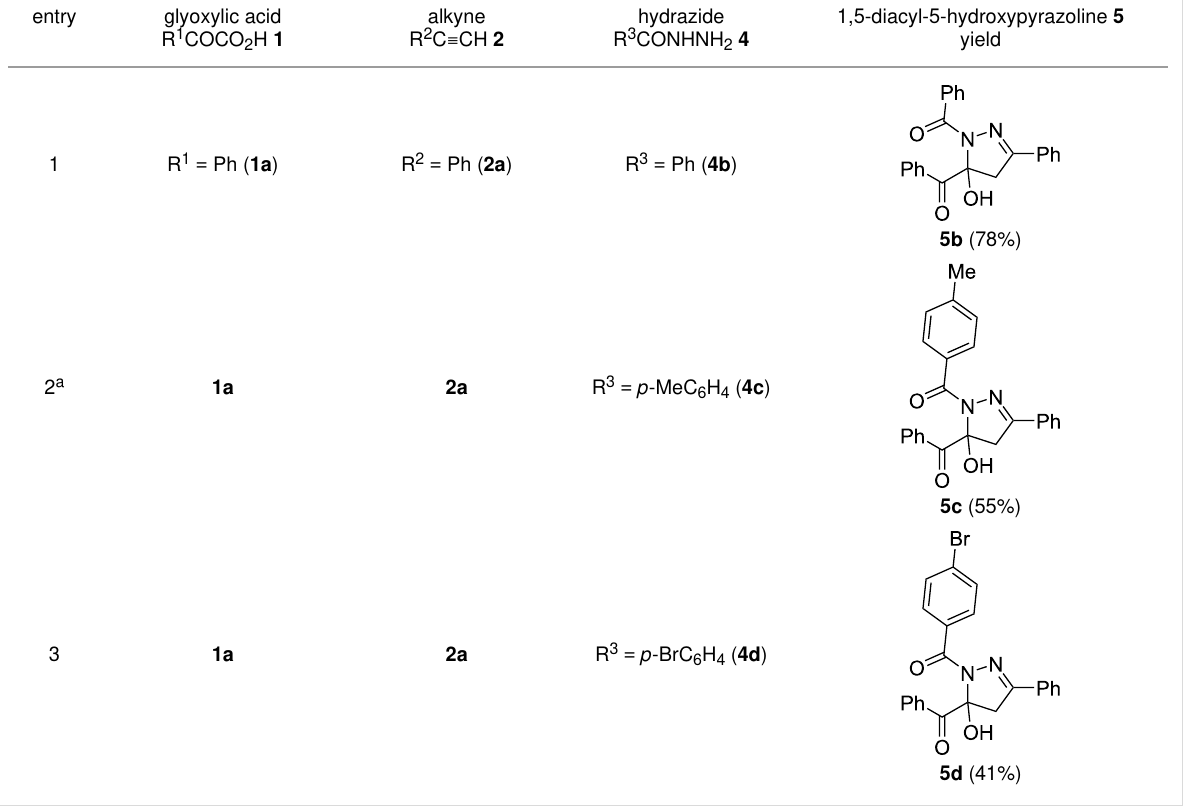
Table 3: Consecutive three-component synthesis of 1,5-diacyl-5-hydroxypyrazolines 5